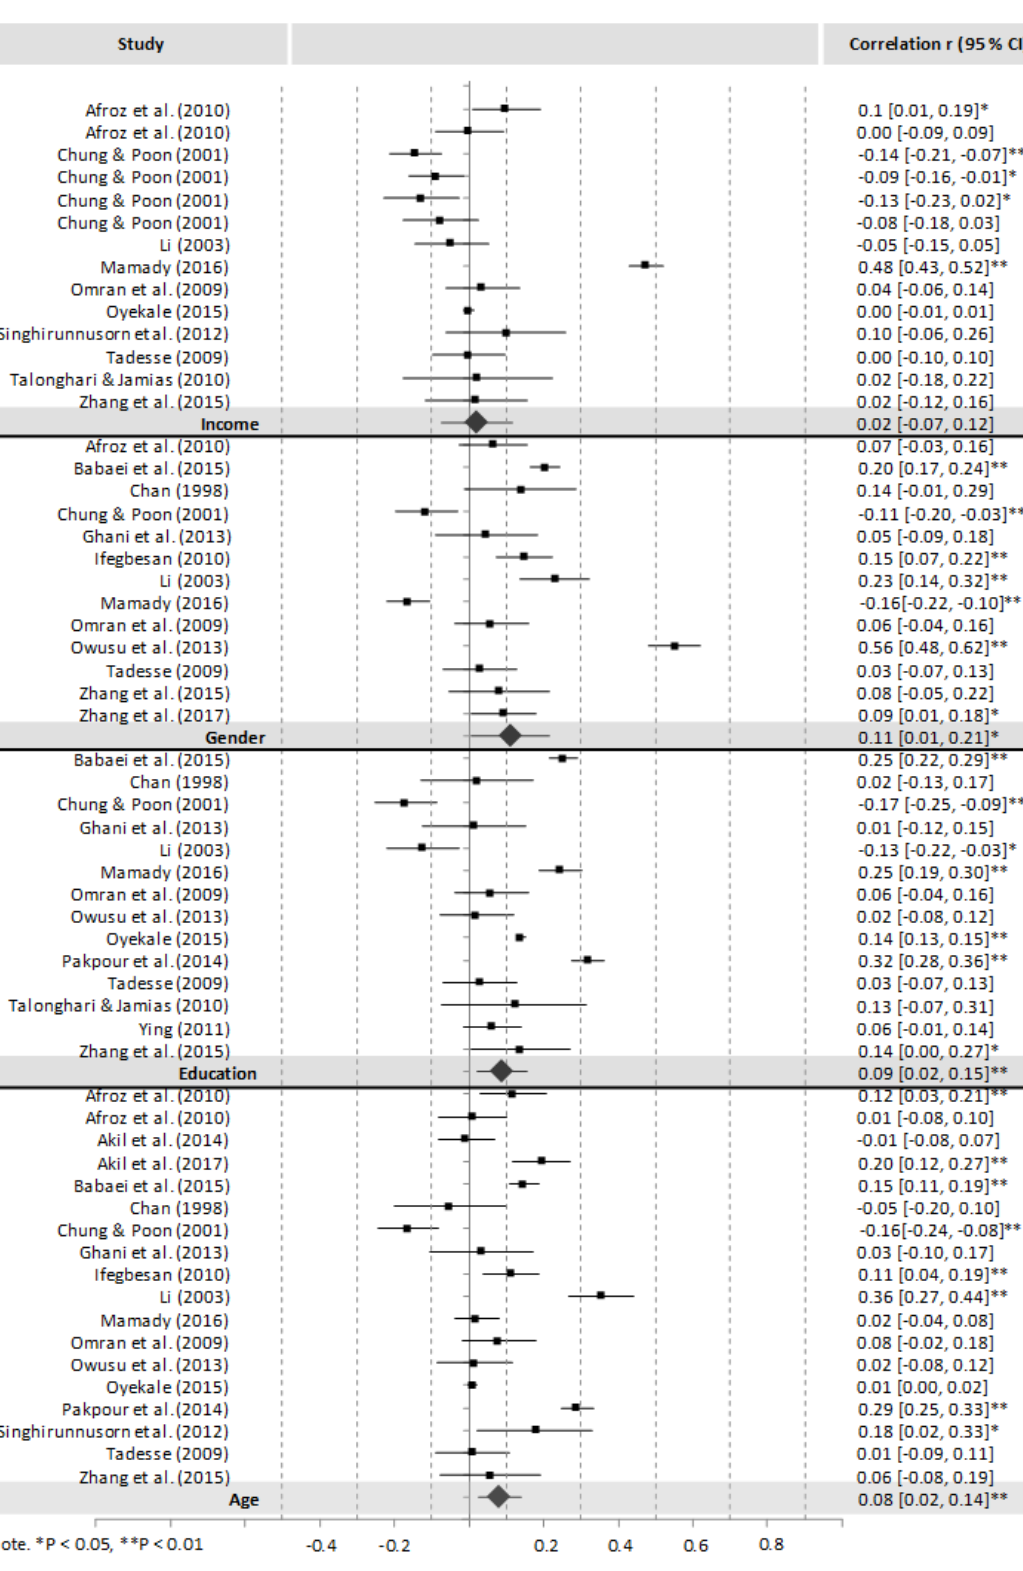
Figure A1. Factors investigated and included in this meta-analysis. The e ff ect-size and 95% confidence interval (CI) was calculated for each study. The overall synthesized for each factor shows under a group of studies; it is highlighted and